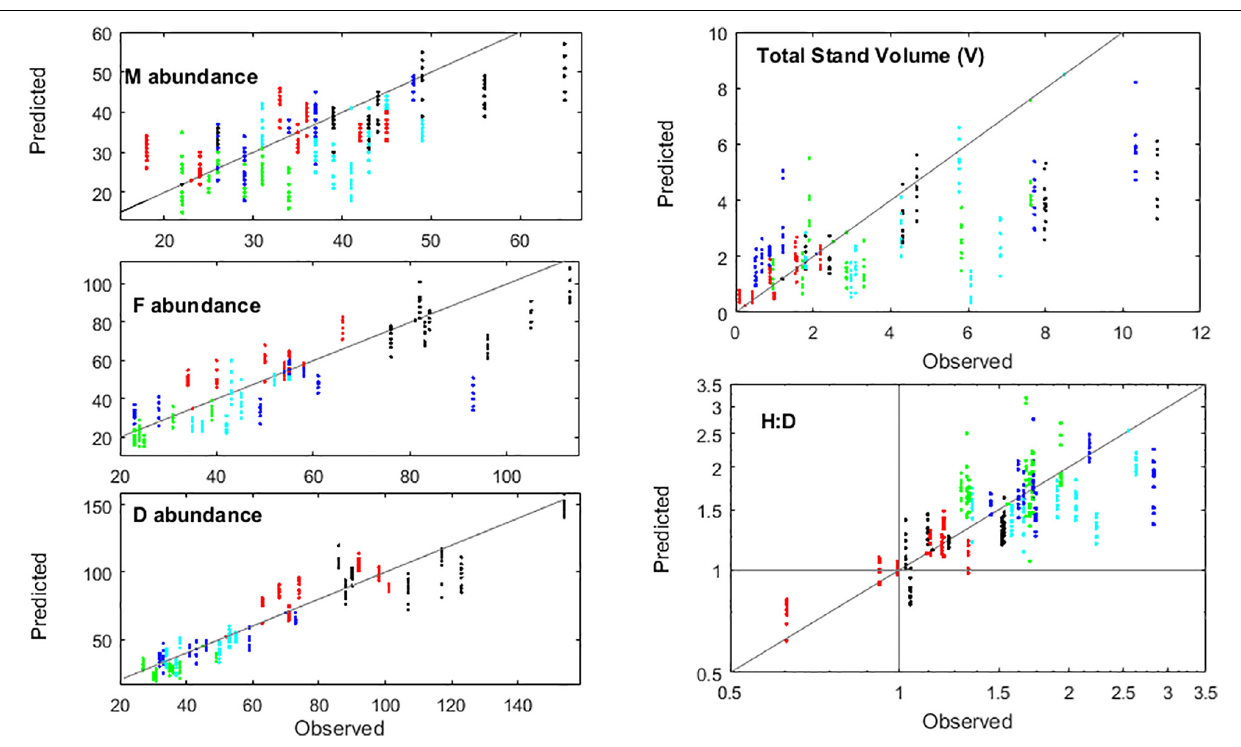
FIGURE 8 | Validation of the IBM run in full mode, based on the predicted abundances of males (M), females (F) and diploids (D), on the total volume of fronds per m 2 of algal stand (V), and the ratio of haploids to diploids (H:D). Markers represent plots Corral 1 (black), Corral 2 (red), Niebla 1 (green), Niebla 2 (light blue), and Niebla 3 (dark blue). The H:D plot in a log scale represents better the H:D dynamics (see Vieira et al.,